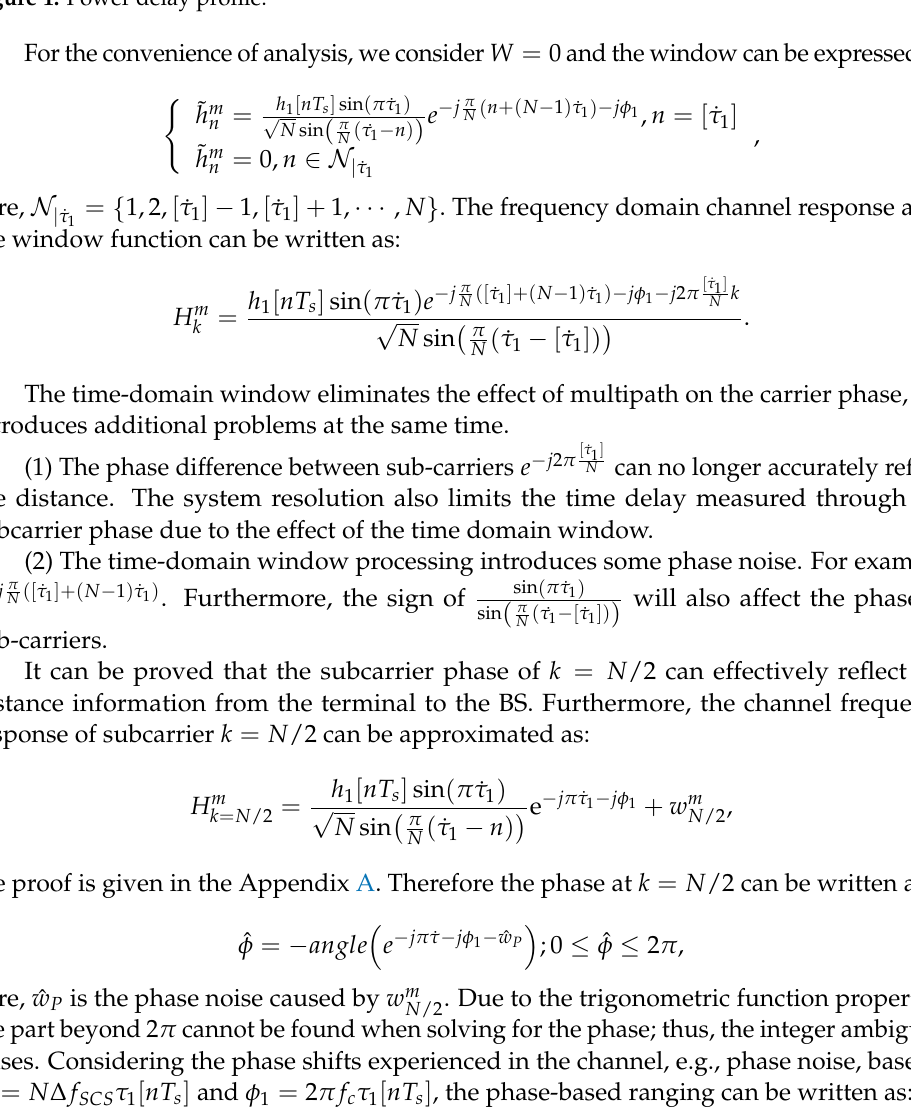
Figure 1. Power delay